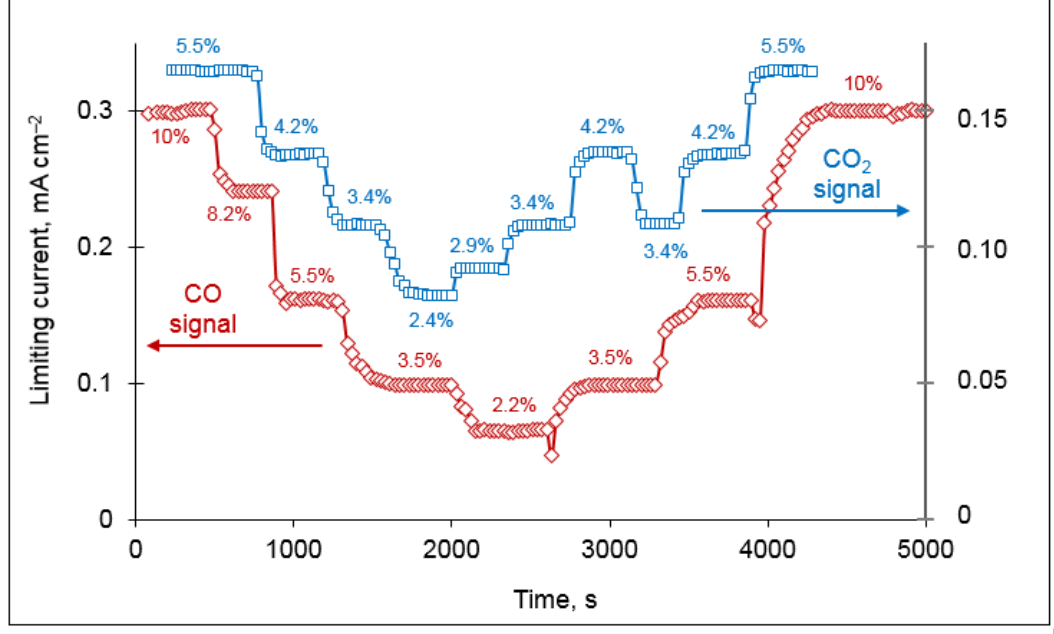
Figure 9. Dynamic response of the sensor signal to changes in concentrations of CO and CO 2 at 600 °C. Error bars are smaller than the symbol size.